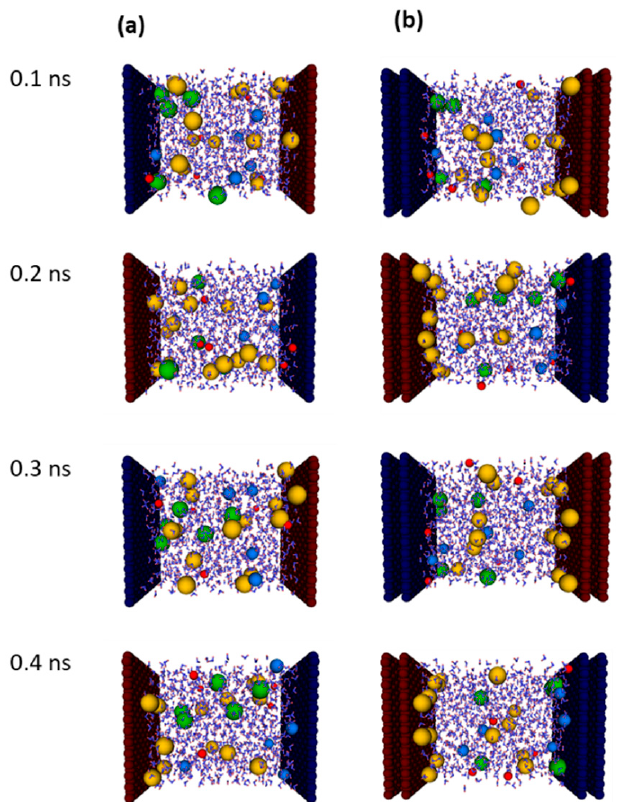
Figure 5. Snapshots of aqueous electrolytes between ( a ) single-layer graphene and ( b ) bilayer graphene electrodes. Li, Na, K, and Cl ions are represented by red, blue, green, and yellow spheres. H 2 O is illustrated by blue and red sticks. The graphene wall with positive and negative partial charges is shown by dark red and blue spheres, respectively, representing carbon atoms.